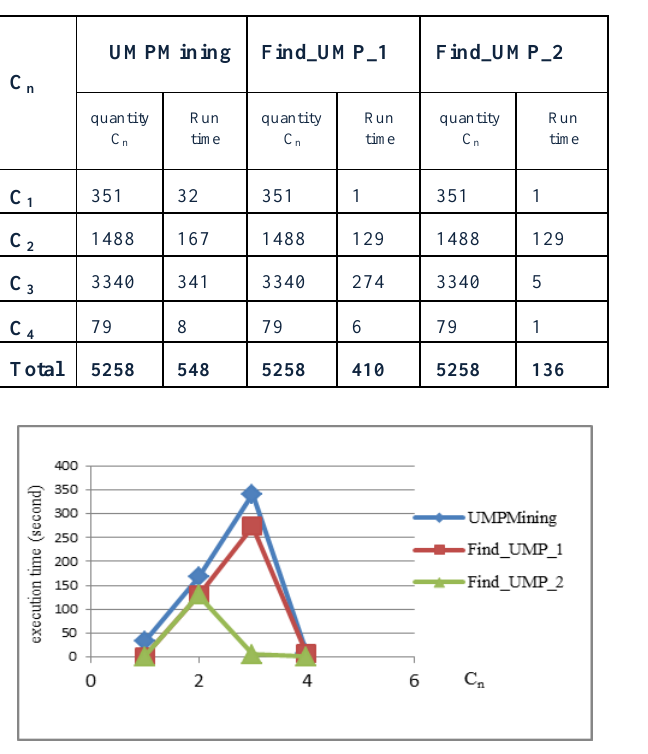
Figure 3 . The execution time results of three algorithms